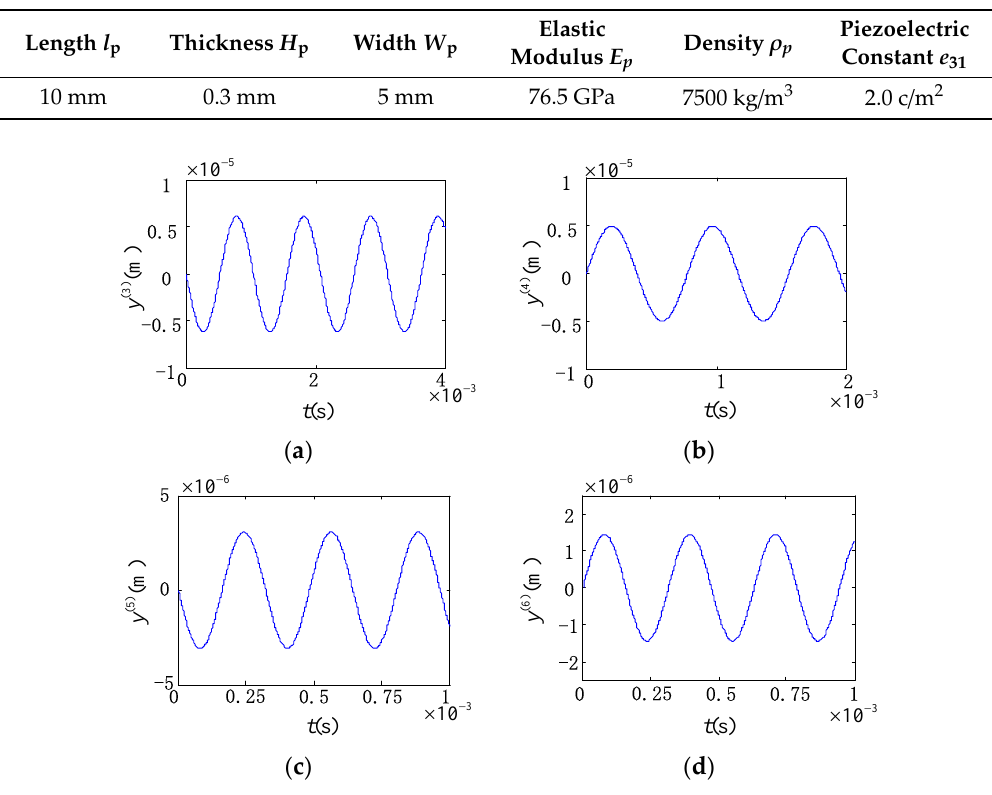
Figure 6. 3rd~6th order forced response image of the cantilever touch beam. ( a ) Third-order forced response; ( b ) Fourth-order forced response; ( c ) Fifth-order forced response; ( d ) Sixth-order forced response.